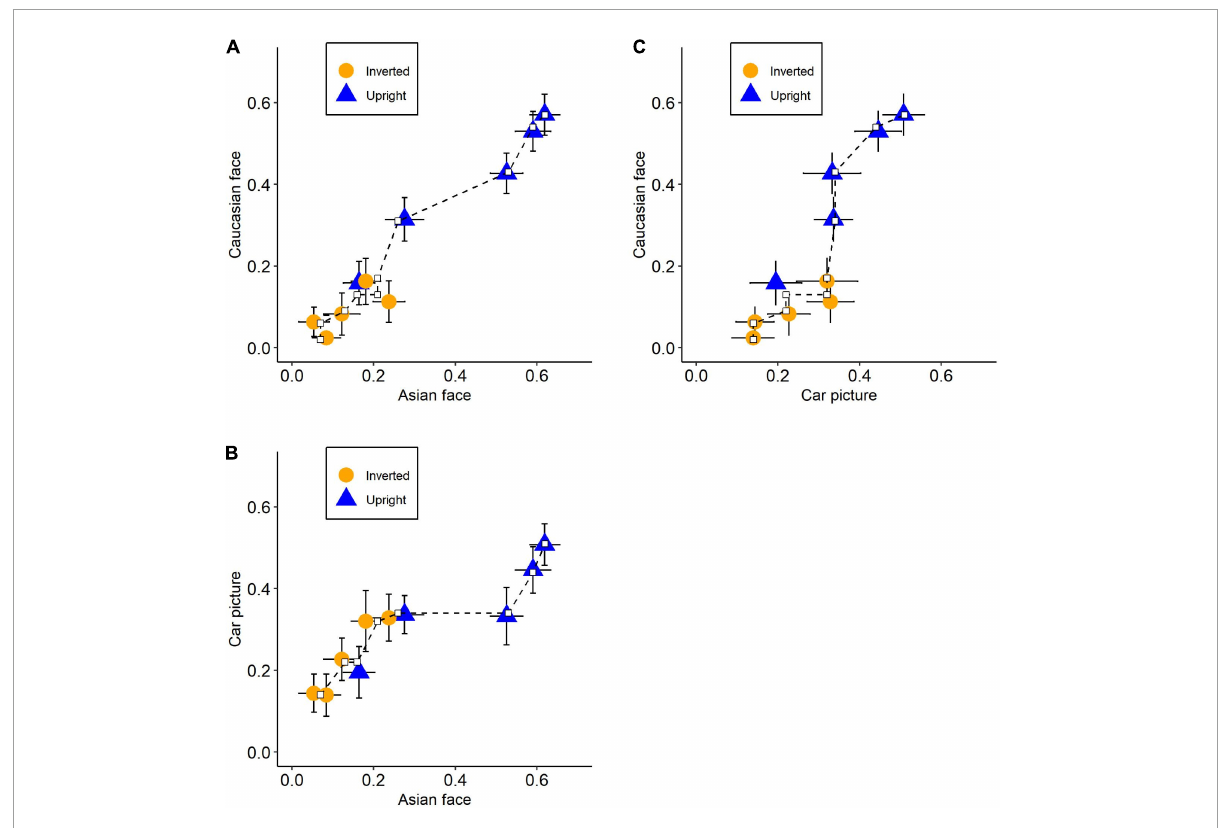
FIGURE4 State trace plots for each pair of stimuli types. The axis represents the recognition performance ( p r ) of its corresponding stimuli types. Plots between recognition performance on (A) Asian faces and Caucasian face, (B) Asian faces and Car front pictures, and (C) Caucasian faces and Car front pictures. Orange circles: inverted condition; Blue triangles: upright condition. Error bars indicate standard errors and dash lines represent the best-fitting monotonic